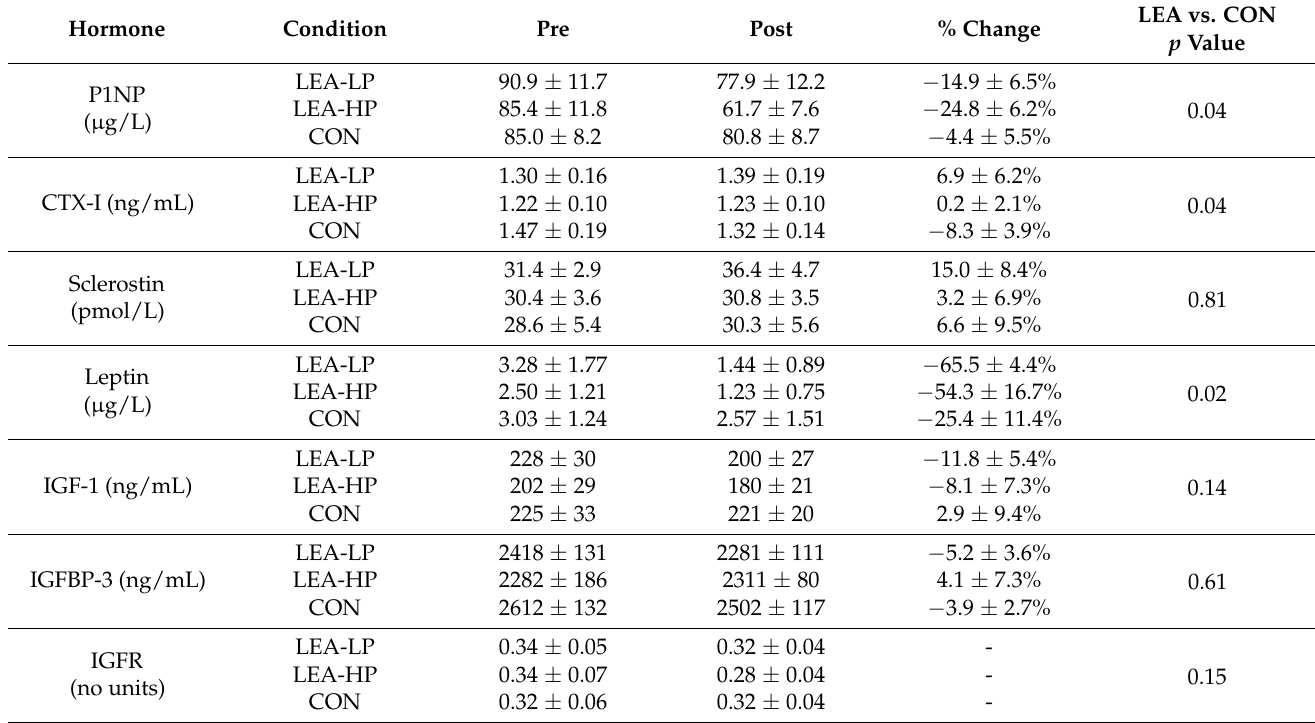
Table 2. Biomarker responses to each